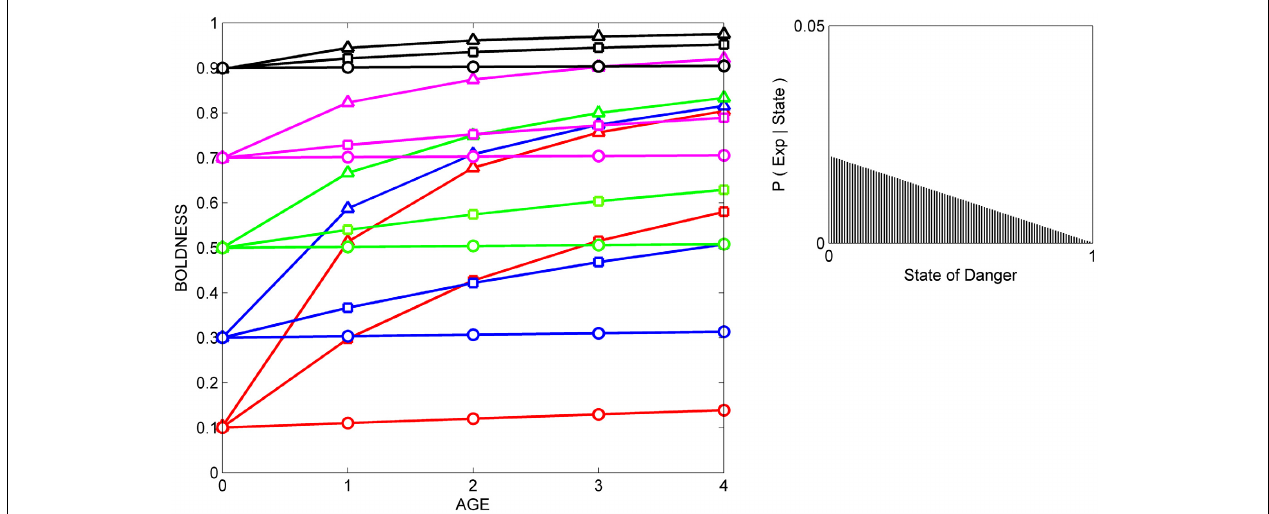
FIGURE 2 | Developmental trajectories for boldness resulting from repeated exposure to cues indicative of safety. Fifteen hypothetical individuals with different prior distributions at birth are repeatedly exposed to the same cue, and their boldness is recorded at 5 ages across ontogeny. The mean of each prior distribution (and the resulting mean level of behavior at age 0) is indicated by color (red: 0.1, blue: 0.3, green: 0.5, magenta: 0.7, black: 0.9); the variance of each prior distribution is indicated by symbols (circles: